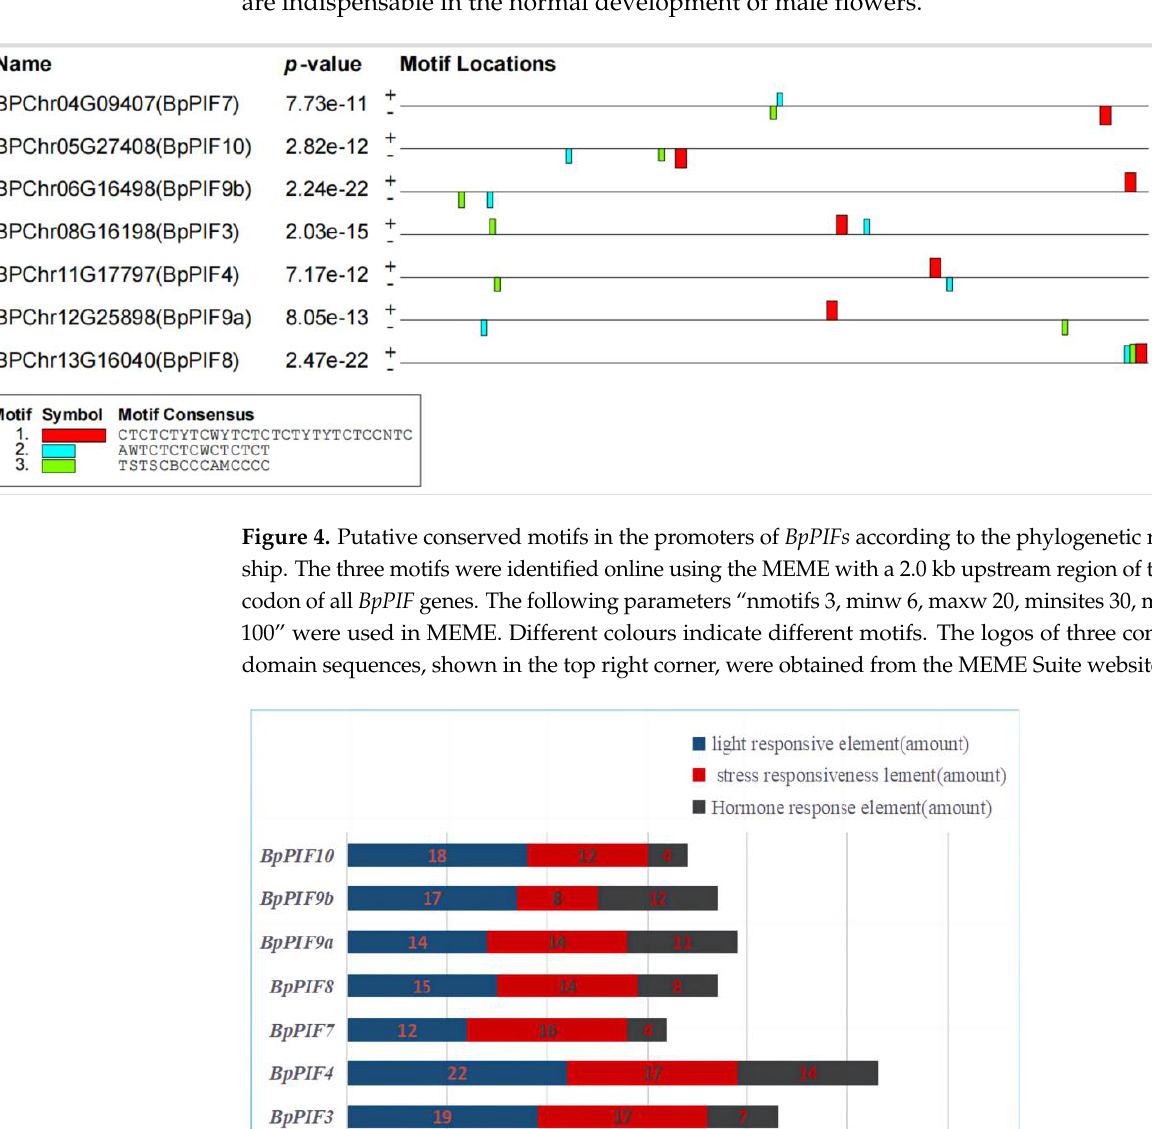
Figure 5. Cis-elements in the promoter of BpPIF genes that are related to stress responses and plant development. The X-axis represents the number of cis-acting elements.